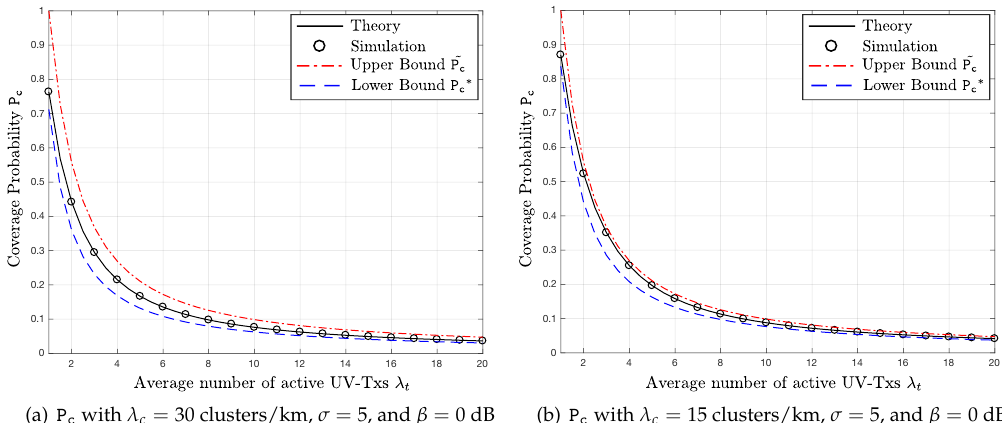
Figure 3. P c versus λ t : comparison with the upper and lower